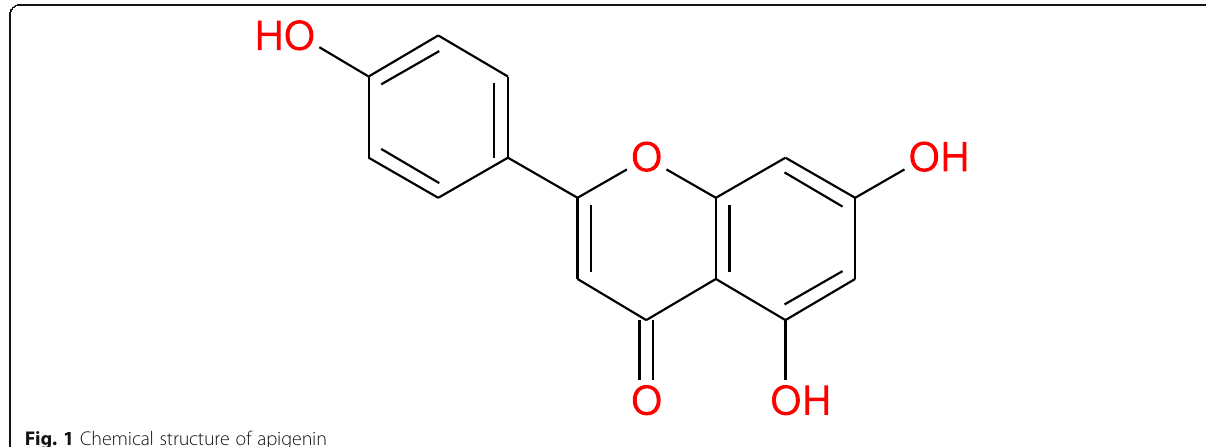
Fig. 1 Chemical structure of apigenin